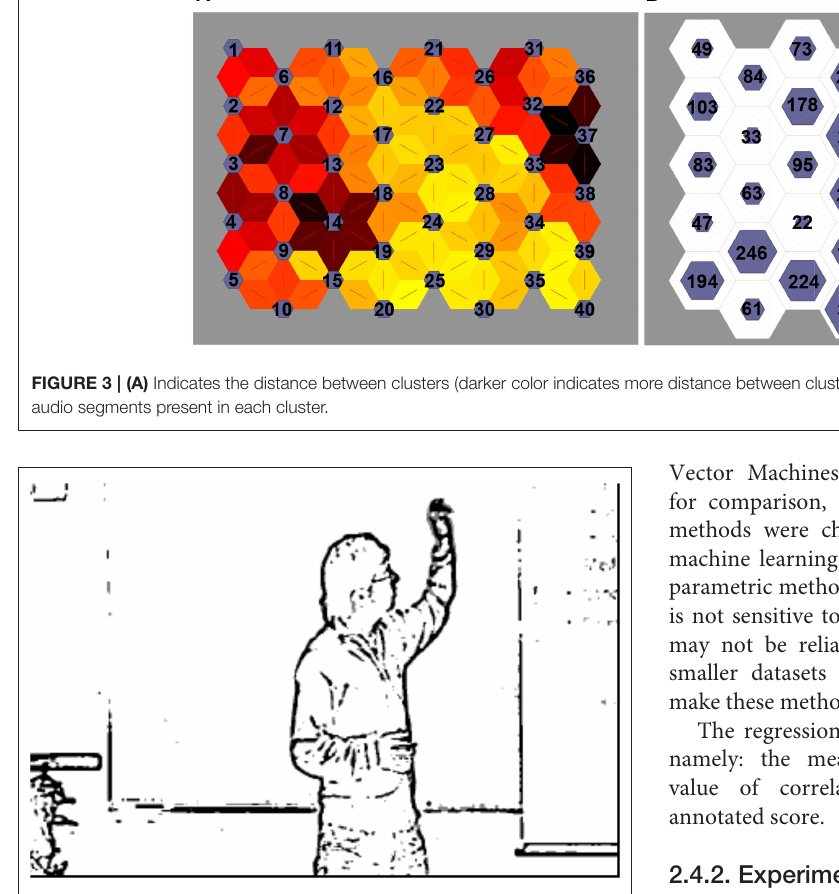
FIGURE 4 | An image from a pre-processed